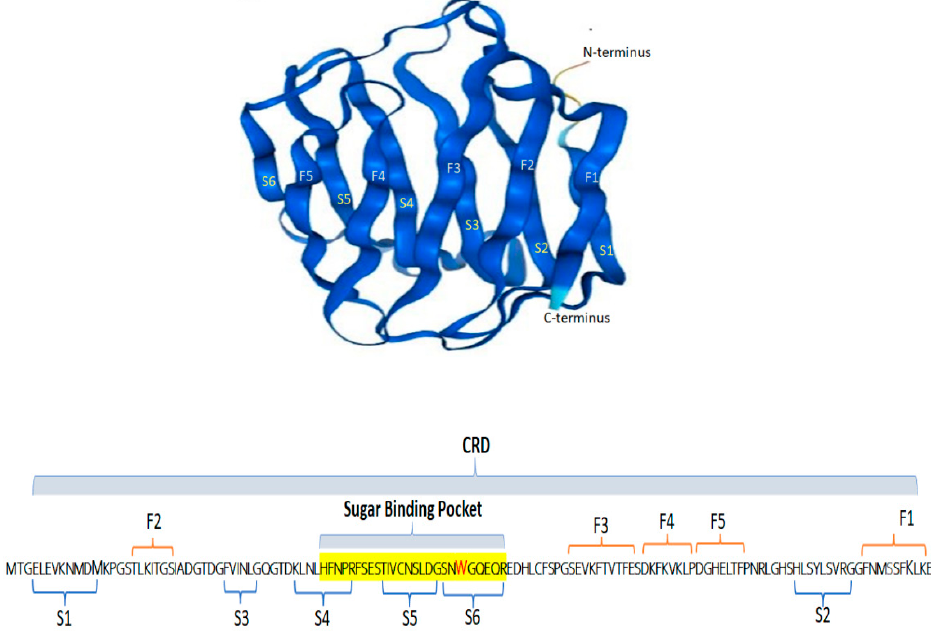
Figure 1. The structure of human galectin-2. The top panel shows galectin-2 molecule in 3D (Protein Atlas HGNC:6562) with the two beta sheets S1–S6 and F1–F5 marked. The bottom panel shows the galectin-2 amino acid sequence with mapped regions of the two beta sheets and the sugar binding pocket (with the tryptophan Trp65 residue in red).